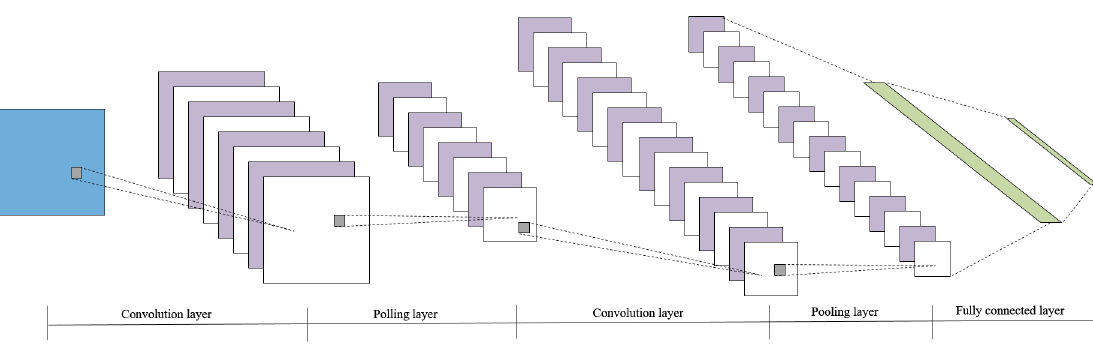
Figure 2. The typical CNN